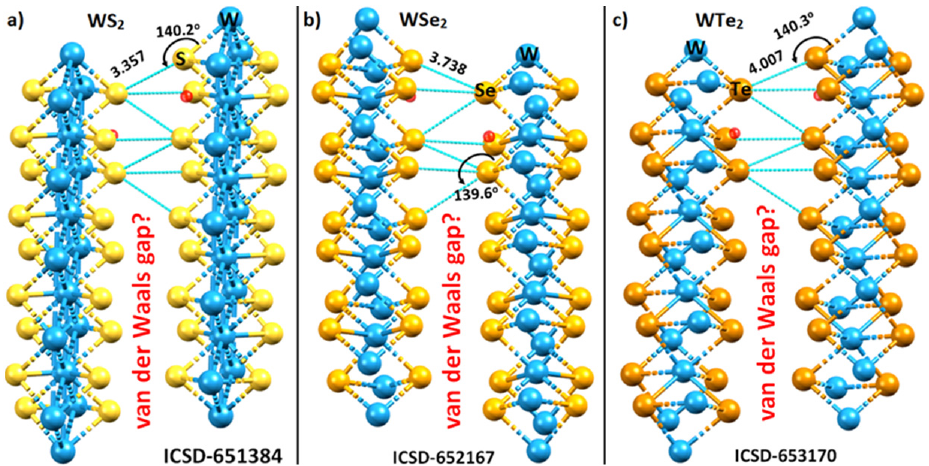
Figure 2. The nature of the interfacial (or interlayer) Ch···Ch bonding interactions between the metal bonded Ch (Ch = S, Se, Te) sites of the two monolayers in the 2H-WCh 2 crystals: ( a ) WS 2 ; ( b ) WSe 2 ; and ( c ) WTe 2 . Selected Ch···Ch bond distances (Å) and ∠ W–Ch···Ch bond angles (degrees) are shown. All Ch ··· Ch interlayer distances are equivalent for a given WCh 2 crystal. The ICSD reference code is shown for each case. The so-called van der Waals gap between the chalcogenide layers is depicted in each occasion. Crystallographic axes are not shown.